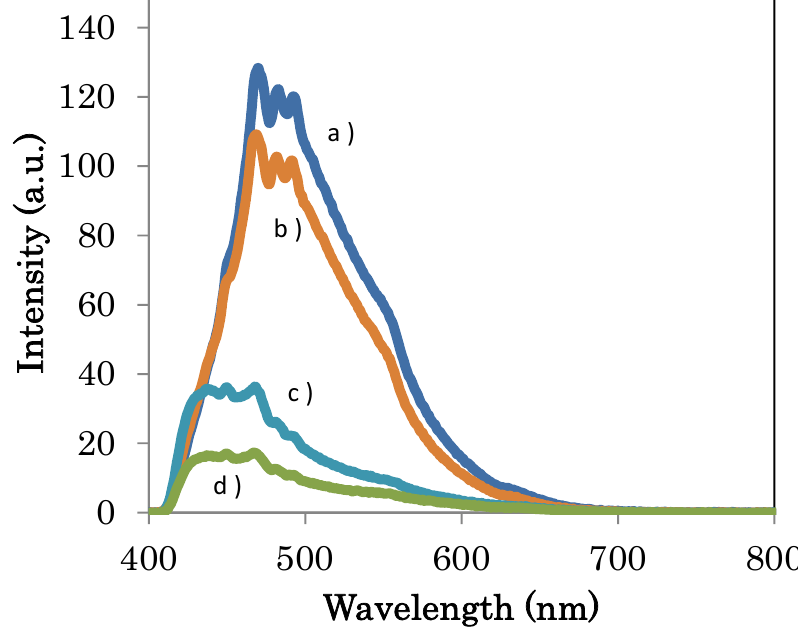
Figure 5. Photoluminescence spectra for ( a ) ZnIn 2 S 4 , ( b ) Zn 0.87 In 2 S 3.87 , ( c ) Zn 0.87 Cu 0.13 In 2 S 3.935 and ( d ) Zn 0.74 Cu 0.13 In 2 S 3.805 . Excitation: 350 nm.